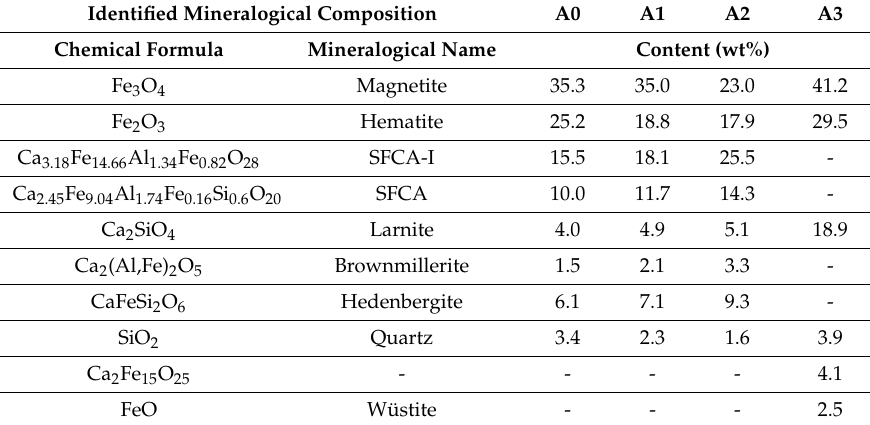
Table 7. Mineralogical composition of